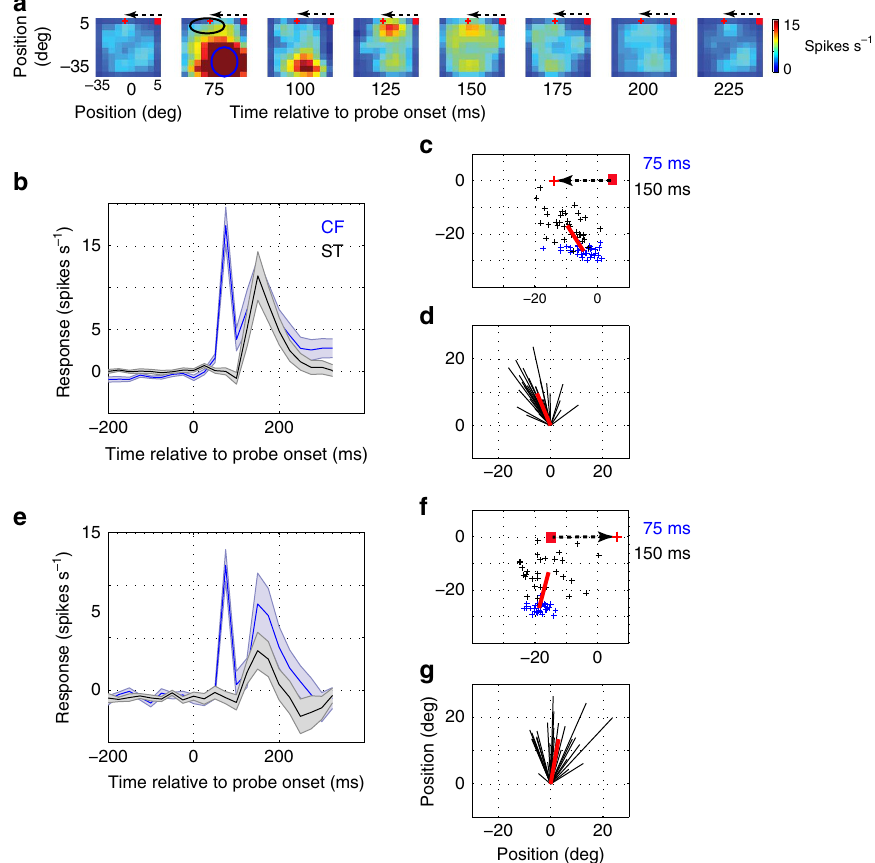
Figure 5 | Receptive field remapping during fixation. ( a ) Time course of the receptive field of an example neuron during fixation. The fixation point is indicated by the red dot, and the saccade target is indicated by the red ‘ þ , which will appear 500–1,000ms after P1 probe onset. Dotted arrow indicates an impending saccade after the target appearance. ( b ) Average temporal dynamics ( n ¼ 35 neurons) of responses to probes flashed at the CF (blue) (indicated by blue circle in the second panel of Fig. 5a) and those at the saccade target (black) (indicated by black circle in the second panel of Fig. 5a) during fixation before towards saccades. ( c ) RF centres at visual latency of 75ms (blue ‘ þ ’) and those at 150ms (black ‘ þ ’) after probe onset during fixation at the red dot. The red line indicates the vector connecting the average RF locations at the two time points after probe onset. ( d ) The black lines represent the vectors connecting the RFs at 75ms and RFs at 150ms after probe onset. RFs at 75ms are aligned for quantifying the average direction of RF shift. ( e ) Average temporal dynamics ( n ¼ 31 neurons) of responses to probes flashed at the CF (blue) and those at saccade target (black) during fixation before away saccades. ( f ) RF centres at visual latency of 75ms (blue ‘ þ ’) and those at 150ms (black ‘ þ ’) after probe onset during fixation at the indicated red dot. ( g ) Same as d . Shades represent s.e.m. across the respective population of